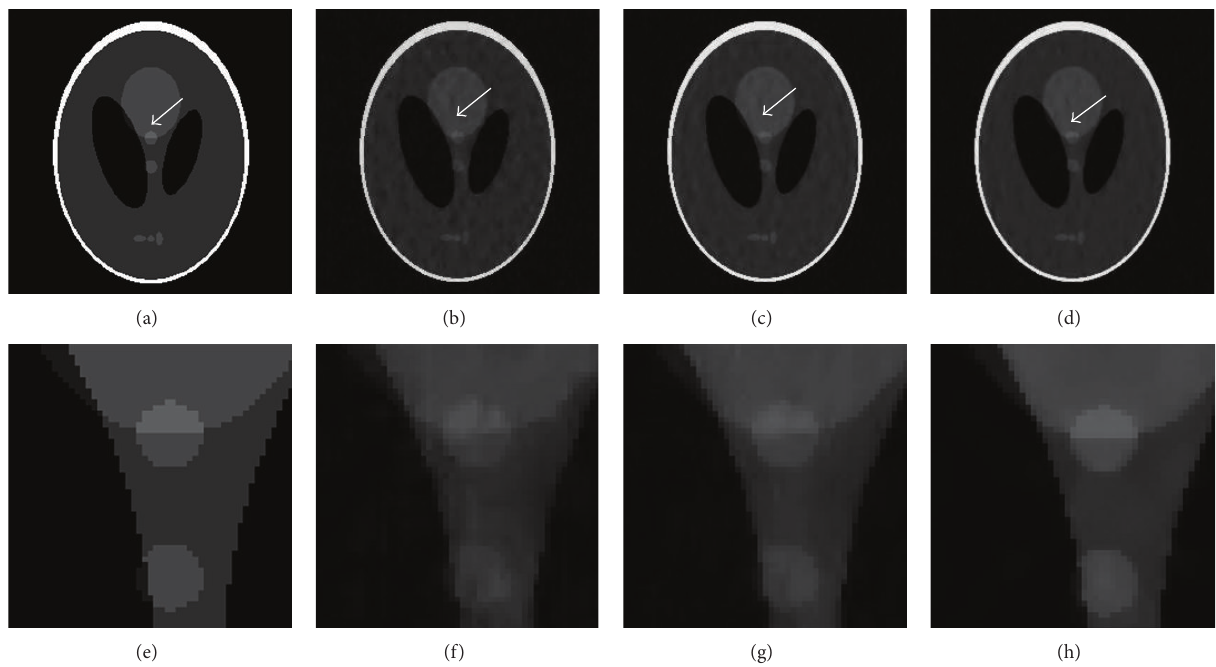
Figure 7: Original Shepp-Logan image and experimental results. (a) Original Shepp-Logan image. Reconstruction at sampling rate 0.2 by (b)